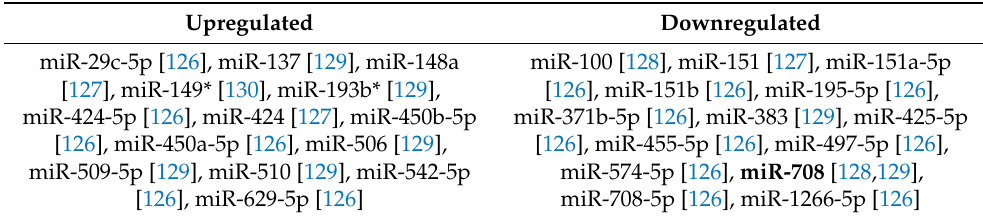
Table 2. The miRNAs that are differentially expressed in T-ALL compared with B-ALL.